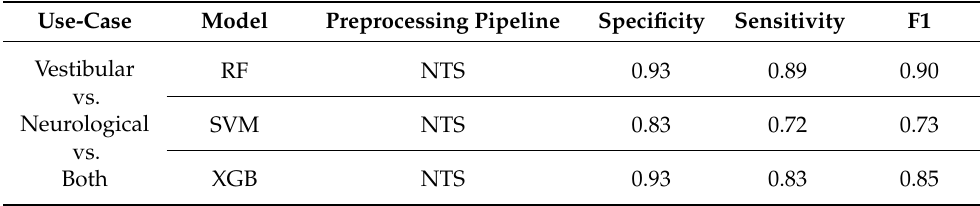
Table 2. Classification performance (sensitivity, specificity, F1) of three different ML models using the NTS data preprocessing pipeline for multiclass prediction of concussion-related impairments. The testing dataset ( n = 18) classes were representative of the training set